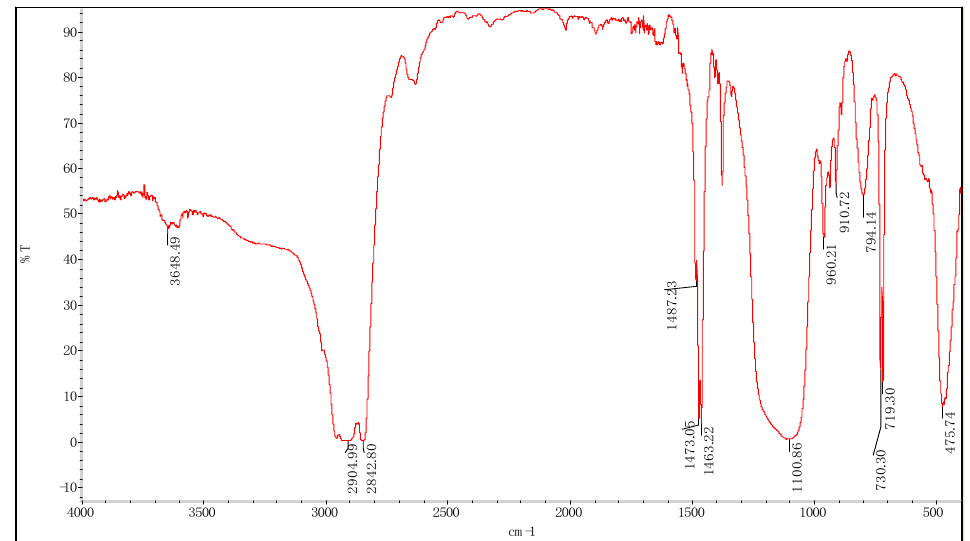
Figure 11. Fourier Transform Infrared Spectra of Silica (Emulsified) Particles.